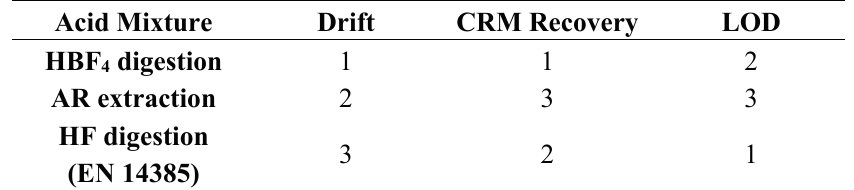
Table 6. Summary comparison of the attributes of the three acid mixtures for sample preparation tested in this paper ranked with performance decreasing in the order: